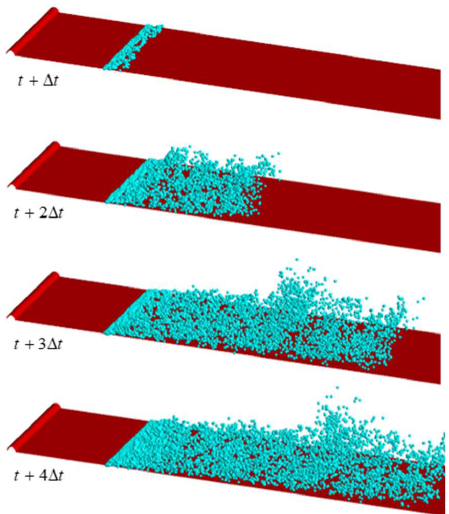
Figure 10. Distribution of microbubbles at four di ff erent moments. The quantity rate of microbubbles is 5 × 10 6 s − 1 . Their size is set to a normal distribution with a standard deviation of